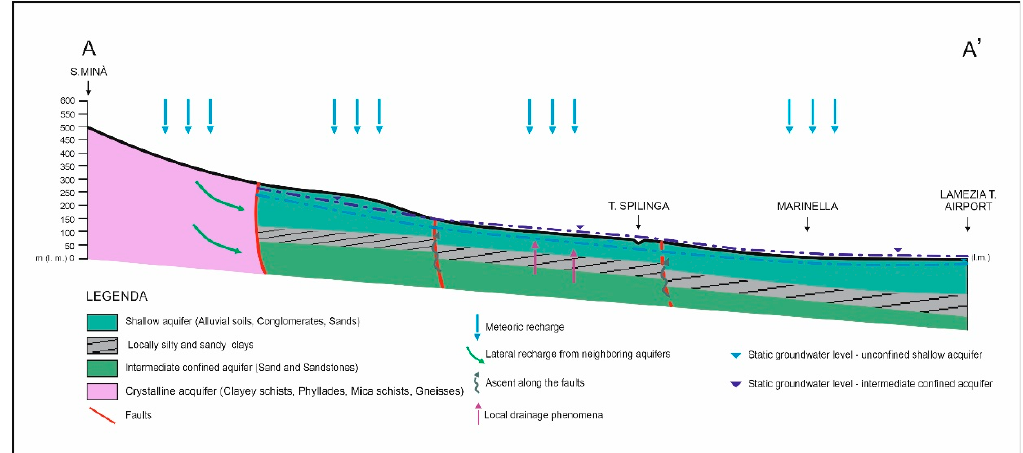
Figure 4. Schematic Hydrogeological Section of the S. E. Lamezia Plain Aquifer (Modified) [11]. The presence of silt-clayey lithotypes tends to generate an underground water circu- lation pattern with a muti-layer aquifer [1,11, 12, 13, 14, 15]. The subject of this study is the southern sector of the shallow aquifer, placed just below ground level in the S. Eufemia Lamezia plain (Figure 5).